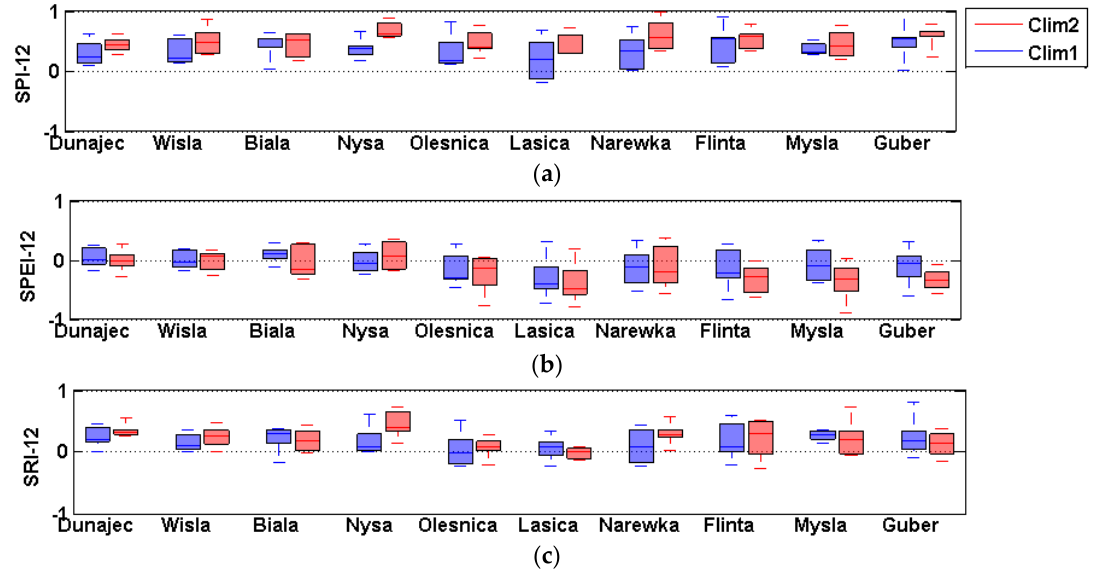
Figure 6. A comparison of the absolute changes of the SPI-12 ( a ); SPEI-12 ( b ) and SRI-12 ( c ) in the median dryness/wetness conditions between two future periods and reference period. In each box, the central red mark denotes a median from seven climate model simulations, the edges of the box are the 25th and 75th percentiles, the whiskers extend to the most extreme data points not considered as outliers, and outliers are plotted individually in the form of red crosses; the x-axis presents the list of ten Polish catchments.